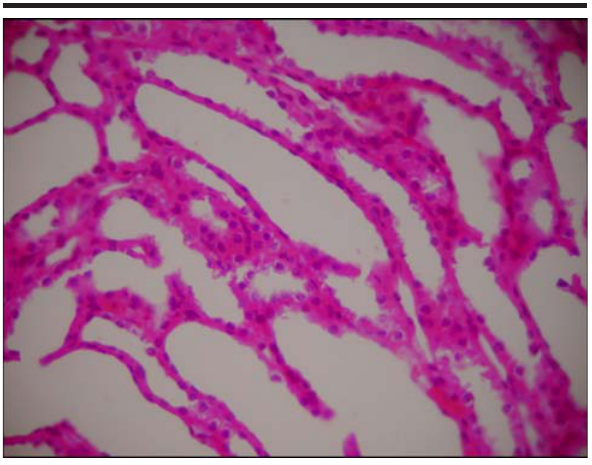
FIGURE 1 - Hemorrhage of 30% of volemia produced tubular dilation in the kidney rat. G1 =